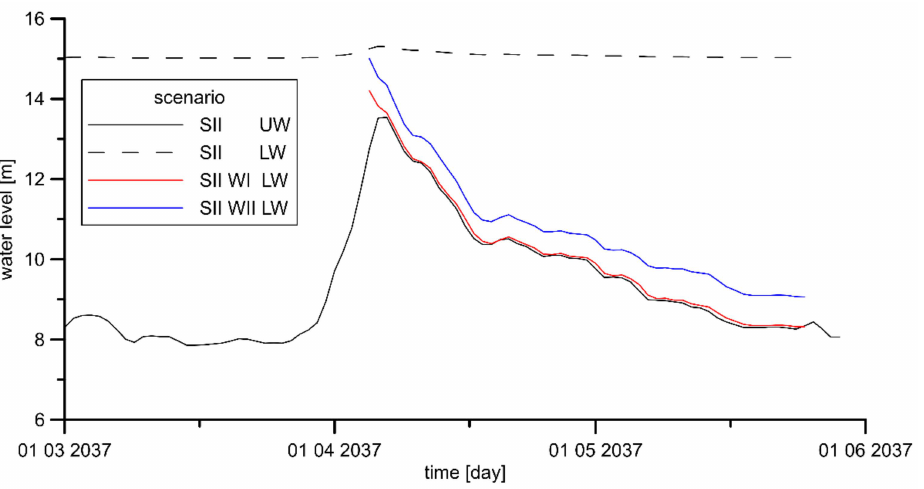
Figure 9. Location of the upper (UW) and lower water (LW) level for options WI and WII, during the flushing process.